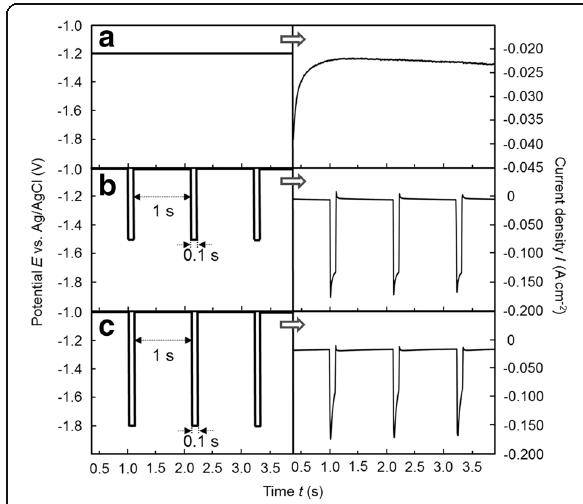
Fig. 4 Time dependence of applied potentials (left-hand side) with observed current density (right-hand side) during Fe nanowire deposition. a Potentiostatic deposition at − 1.2 V, b pulsed potential deposition with the on-time potential of − 1.5 V, and c pulsed potential deposition with the on-time potential of − 1.8